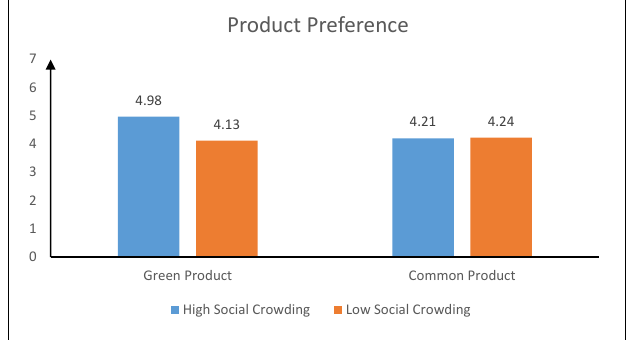
FIGURE 6 | The moderating effect of product